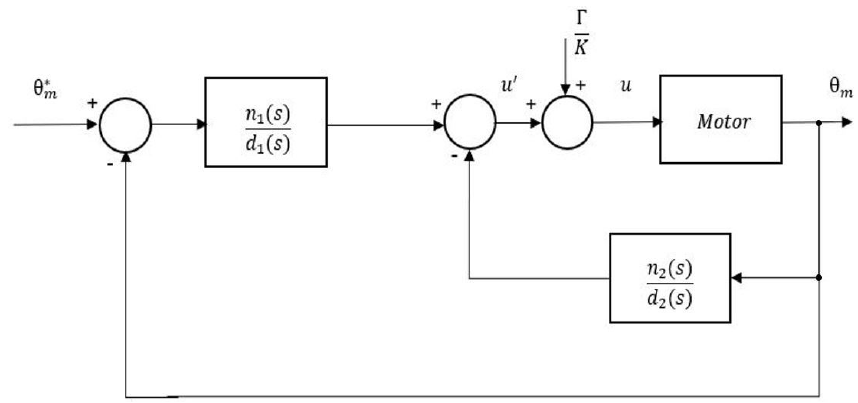
Figure 2. Inner control loop